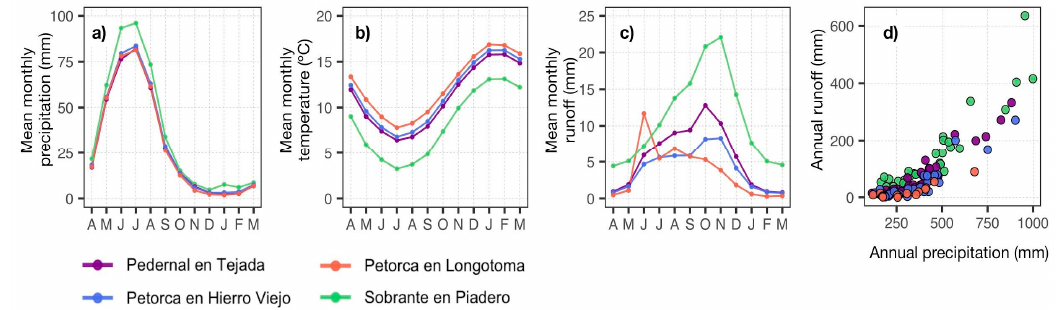
Figure 4. Hydrologic regimes within Petorca basin. ( a ) Mean monthly precipitation, ( b ) mean monthly temperature, and ( c ) mean monthly runoff for the four sub-catchments. Panel ( d ) shows the annual rainfall-runoff relationship for each sub-basin.